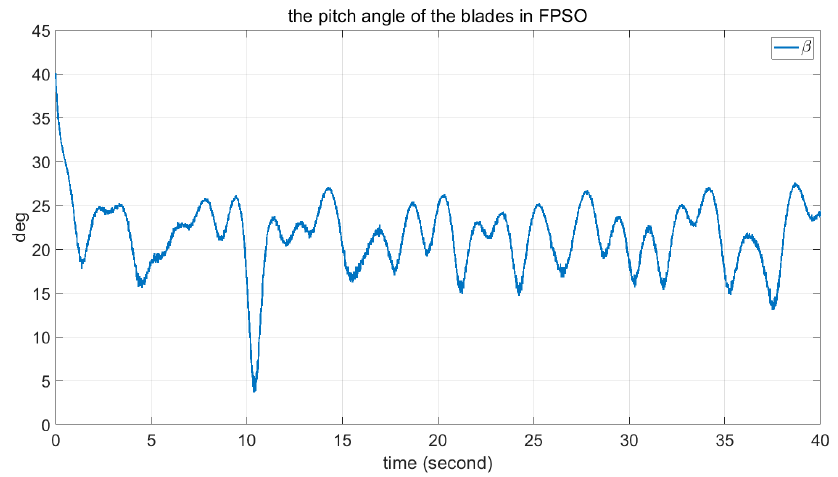
Figure 14. The angle of blades in FPSO. Example 3. The proposed fuzzy TSK